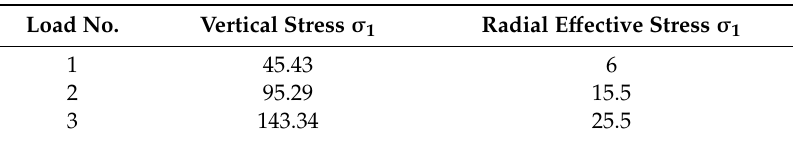
Table 2. Stress conditions at